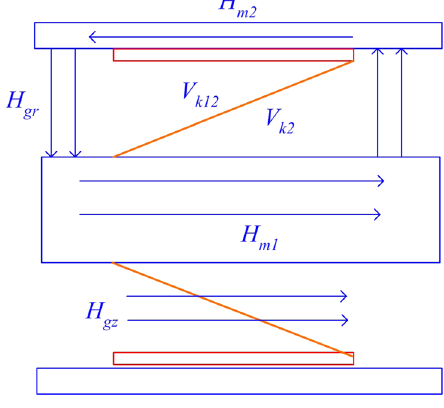
FIG. 1. Structure of the transformer with an open magnetic core.